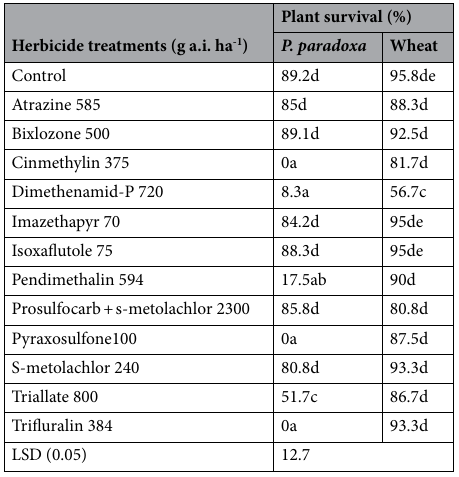
Table 1. Effect of PRE herbicides on the survival of Phalaris paradoxa and wheat seedlings (28 d after spray). The means sharing similar letter(s) are statistically similar.